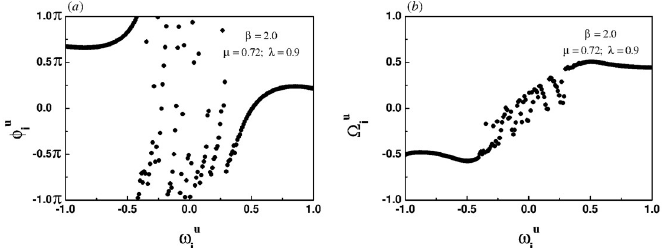
Fig 5. Snapshots of the instantaneous phases (left panel) and the effective frequencies (right panel) for the super- linear correlation when the intra-layer and inter-layer coupling strength are set to 0.72 and 0.9,